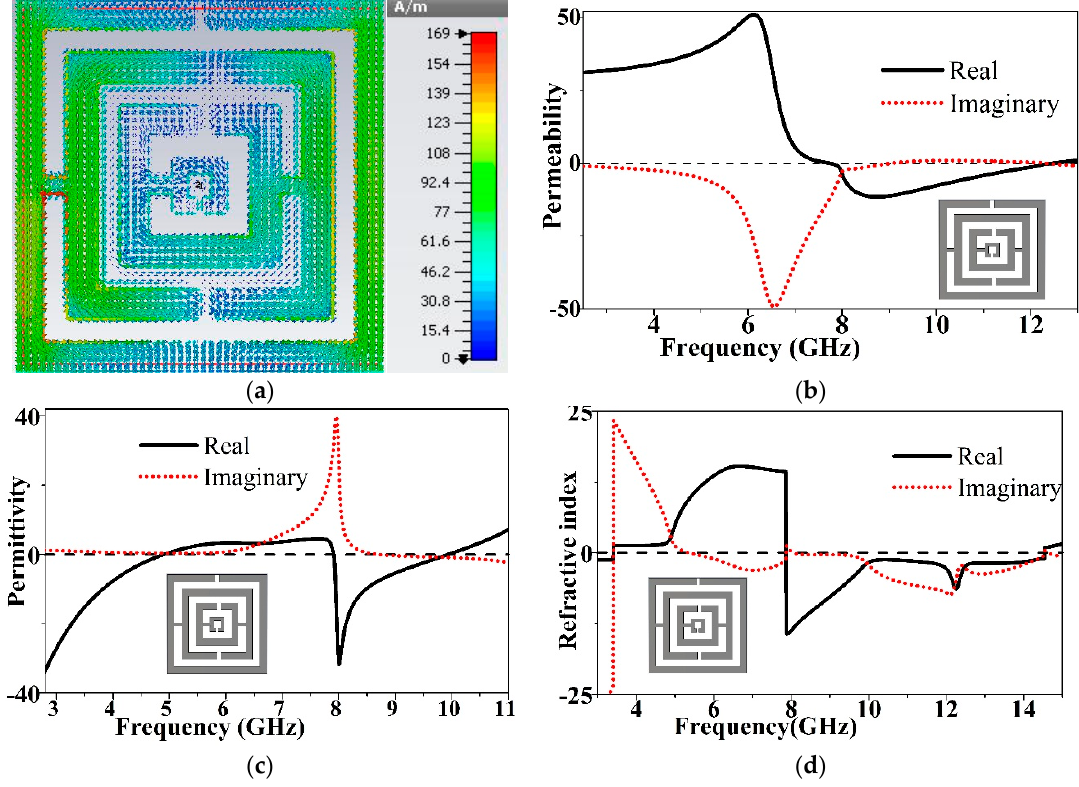
Figure 3. Unit cell characteristics ( a ) Surface current distribution at 8.4 GHz ( b ) Permeability ( c ) Permittivity ( d ) Refractive index.